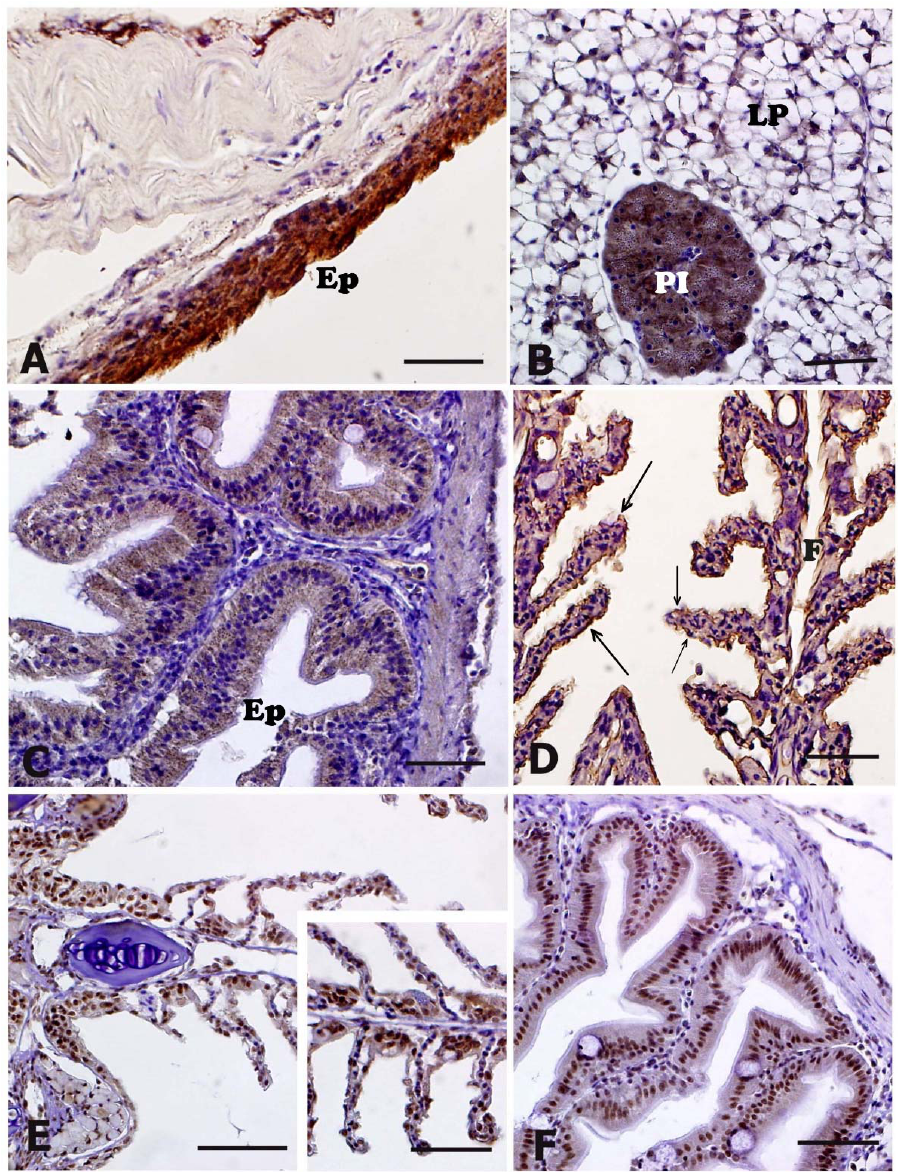
Figure 5. Nitrotyrosine (NT) in panels ( A–D ) and 8-hydroxy-2’-deoxyguanosine (8-OHdG) in panels ( E , F ) immunohistochemical localization in meagre ( Argyrosomus regius ). All panels are counterstained with Mayer’s haematoxylin and represent animals exposed to transport stress. Insert in ( E ) represents a control animal. ( A ) Skin of stressed animals which exhibits a marked NT immunopositivity in the epithelium (Ep). ( B ) Liver and pancreas of a stressed animal showing NT-immunostaining in both hepatocytes of the liver parenchyma (LP) and pancreatic islands (PI). ( C ) Intestine of a transported animal showing a moderate NT-immunostaining in the cytoplasm of enterocytes lining the epithelium (Ep). ( D ) Gills of a transported animal showing NT-immunostaining in the epithelial cells lining both filaments ( F ) and lamellae (arrows). ( E ) Gills of an animal from the stressed group showing 8-OHdG immunopositive nuclei in the epithelial cells lining both filaments and lamellae. Control animal (insert in ( E )) shows a similar positivity. ( F ) 8-OHdG immunopositive nuclei in the epithelial cells lining the intestinal mucosa. Scale bars: ( A – F ) 20 µ M, insert in ( E ) 20 µ M. Immunopositivity to 8-OHdG antibody was detected in the nuclei of: (i) epithelial cells of skin; (ii) epithelial cells lining the gastric mucosa; (iii) epithelial cells lining